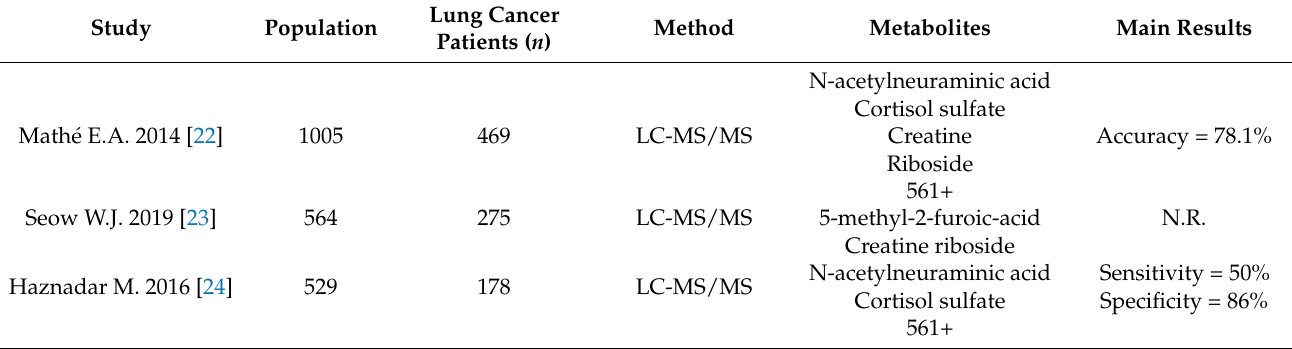
Table 2. Summary of the studies using gas or liquid mass spectrometry for urine metabolite analysis